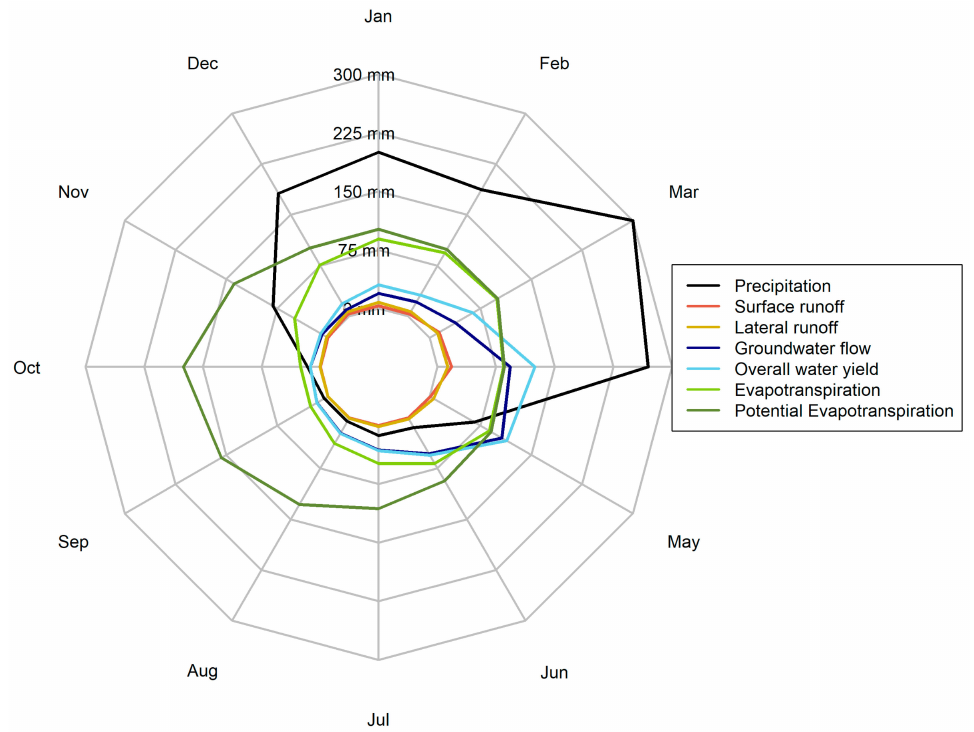
Figure 9. Monthly averages of the water balance components for the Kilombero Catchment within the simulation period